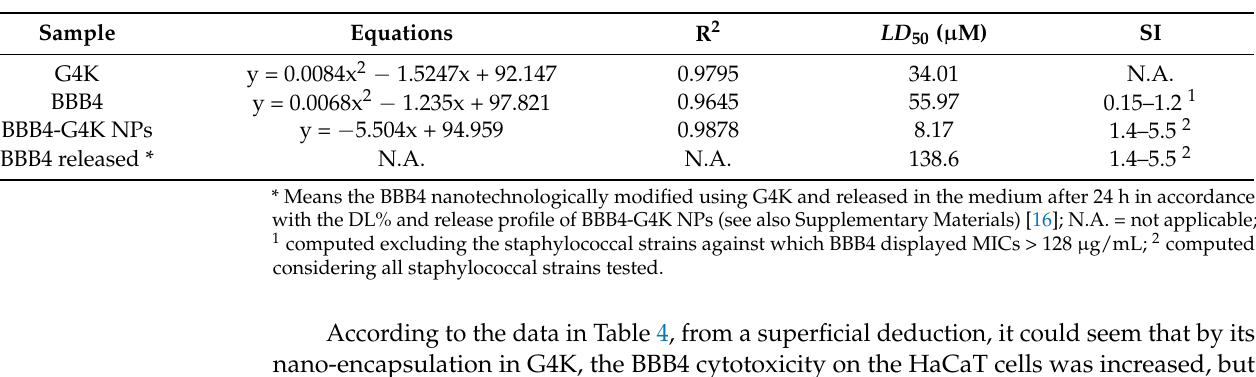
Table 4. Regression’s equations, R 2 values, and LD 50 of G4K, BBB4, and BBB4-G4K NPs and of